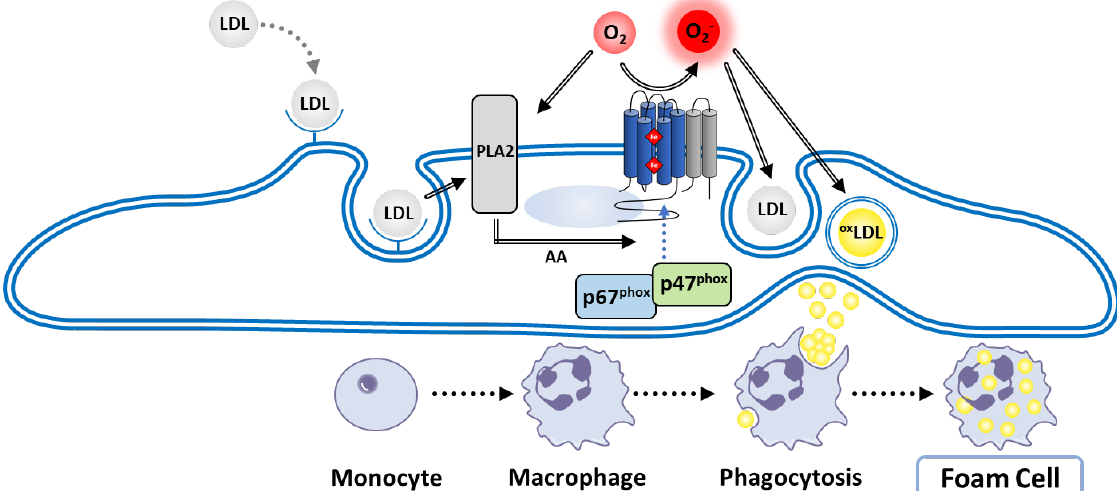
Figure 24. Model of the crucial role of NOX2 in atherogenic EC generation. Atherogenic LDL levels activate the re-lease of intracellular ascorbic acid via phospholipase A2, leading to the translocation of p47 phox and p67 phox to NOX2. The subsequent production of O 2 •− by NOX leads to increased LDL transfer across the EC, during which the exposure of LDL to high levels of O 2 •− may cause oxidation of LDL (ox-LDL) on the abluminal side of the EC. The ox-LDL thus generated is absorbed by macrophages that are attracted by the accumulation of cell adhesion molecules, thus explaining the pro-duction of foamy cells observed in the early stages of atherosclerosis